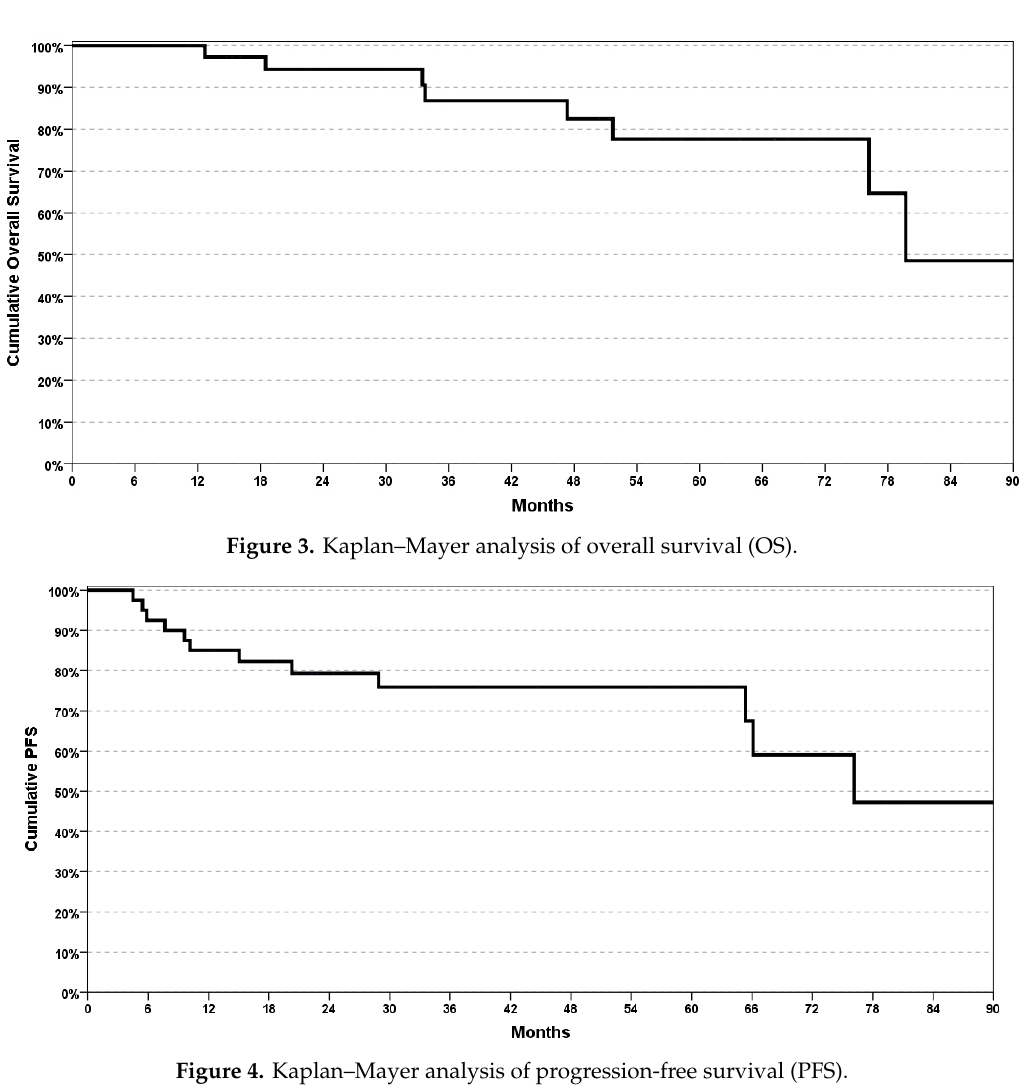
Figure 4. Kaplan–Mayer analysis of progression-free survival (PFS).